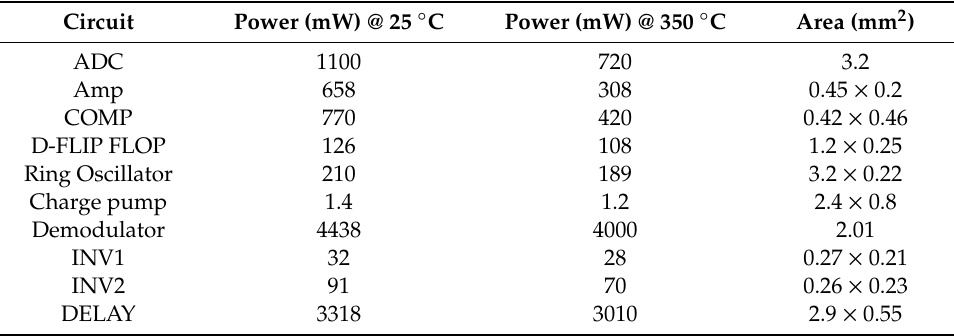
Figure 17. Chip layout view of the proposed data transmission system. Table 2. Power consumption and area of the various system building blocks.